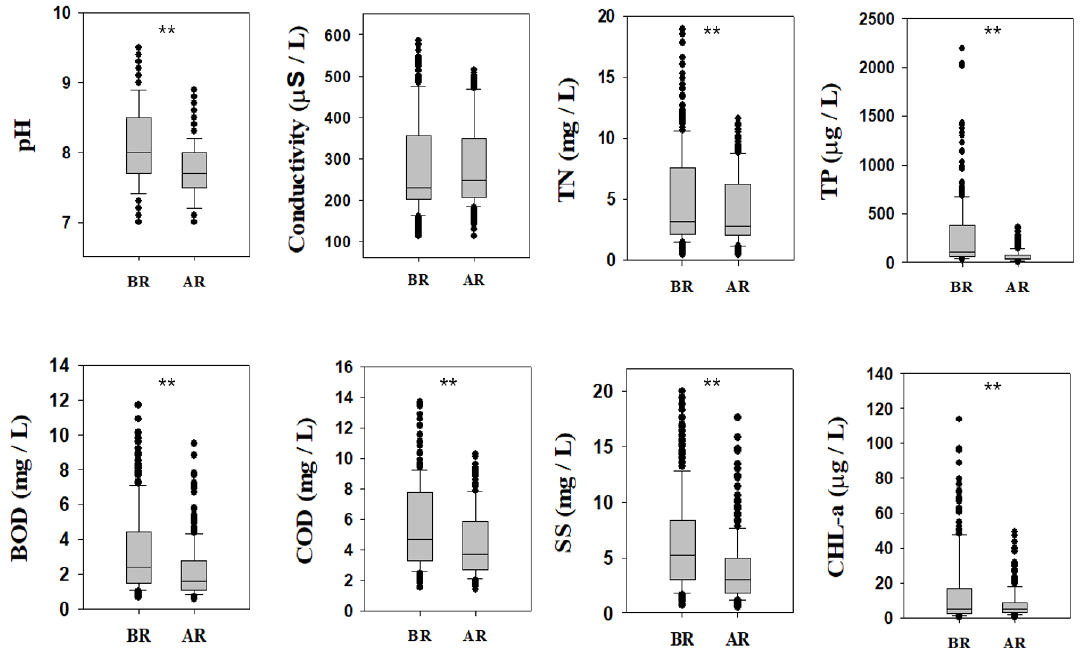
Figure 5. Spatial variation in selected water quality parameters at each sampling site of Gap-stream because of result of restoration measures. (BR = before restoration, 2007–2010; AR = after restoration, 2013–2016, ** = p < 0.01).